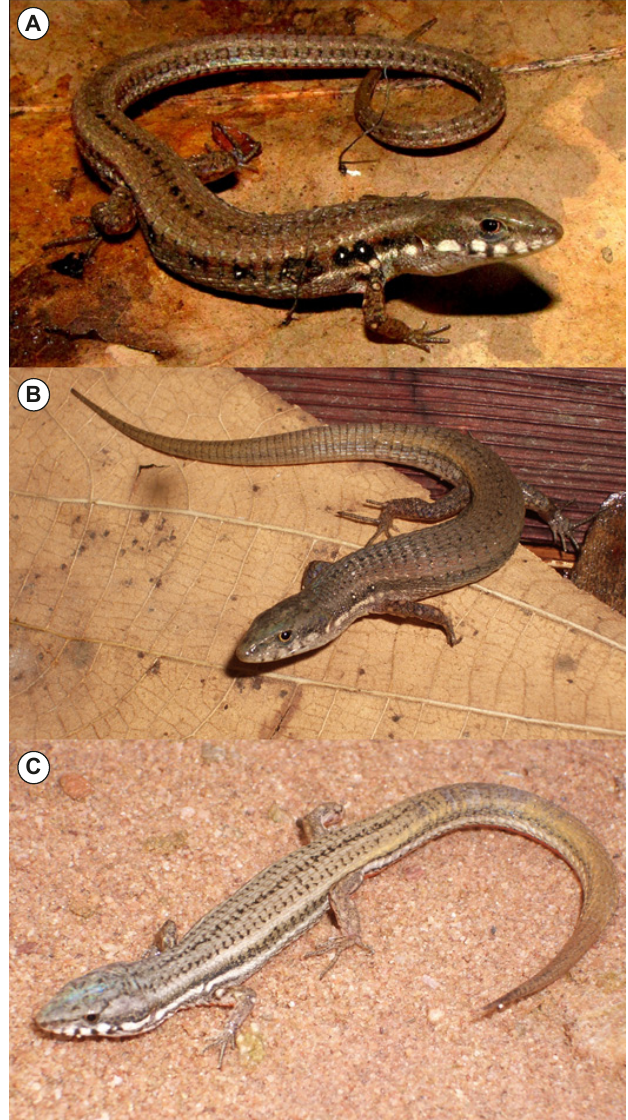
Figure 4. Cercosaura parkeri. Variation in dorsal color pattern of live specimens of (A) Individual from Estação Ecológica da Serra das Araras, Porto Estrela, Mato Grosso, Brazil (UFMT 8318, male, snout-vent length 44.9 mm, tail length 97.7 mm, mass 2.4 g) (photo: R. Valadão); (B) individual (not collected) from Vãozinho, Barra do Bugres, Mato Grosso, Brazil (photo: C. Strüssmann); (C) individual from Projeto São Francisco, Vila Bela da Santíssima Trindade, Mato Grosso, Brazil (UFMT 3016, male, snout-vent length 38.7 mm) (photo: C. Strüssmann). Cercosaura Figure 3. Male individuals of